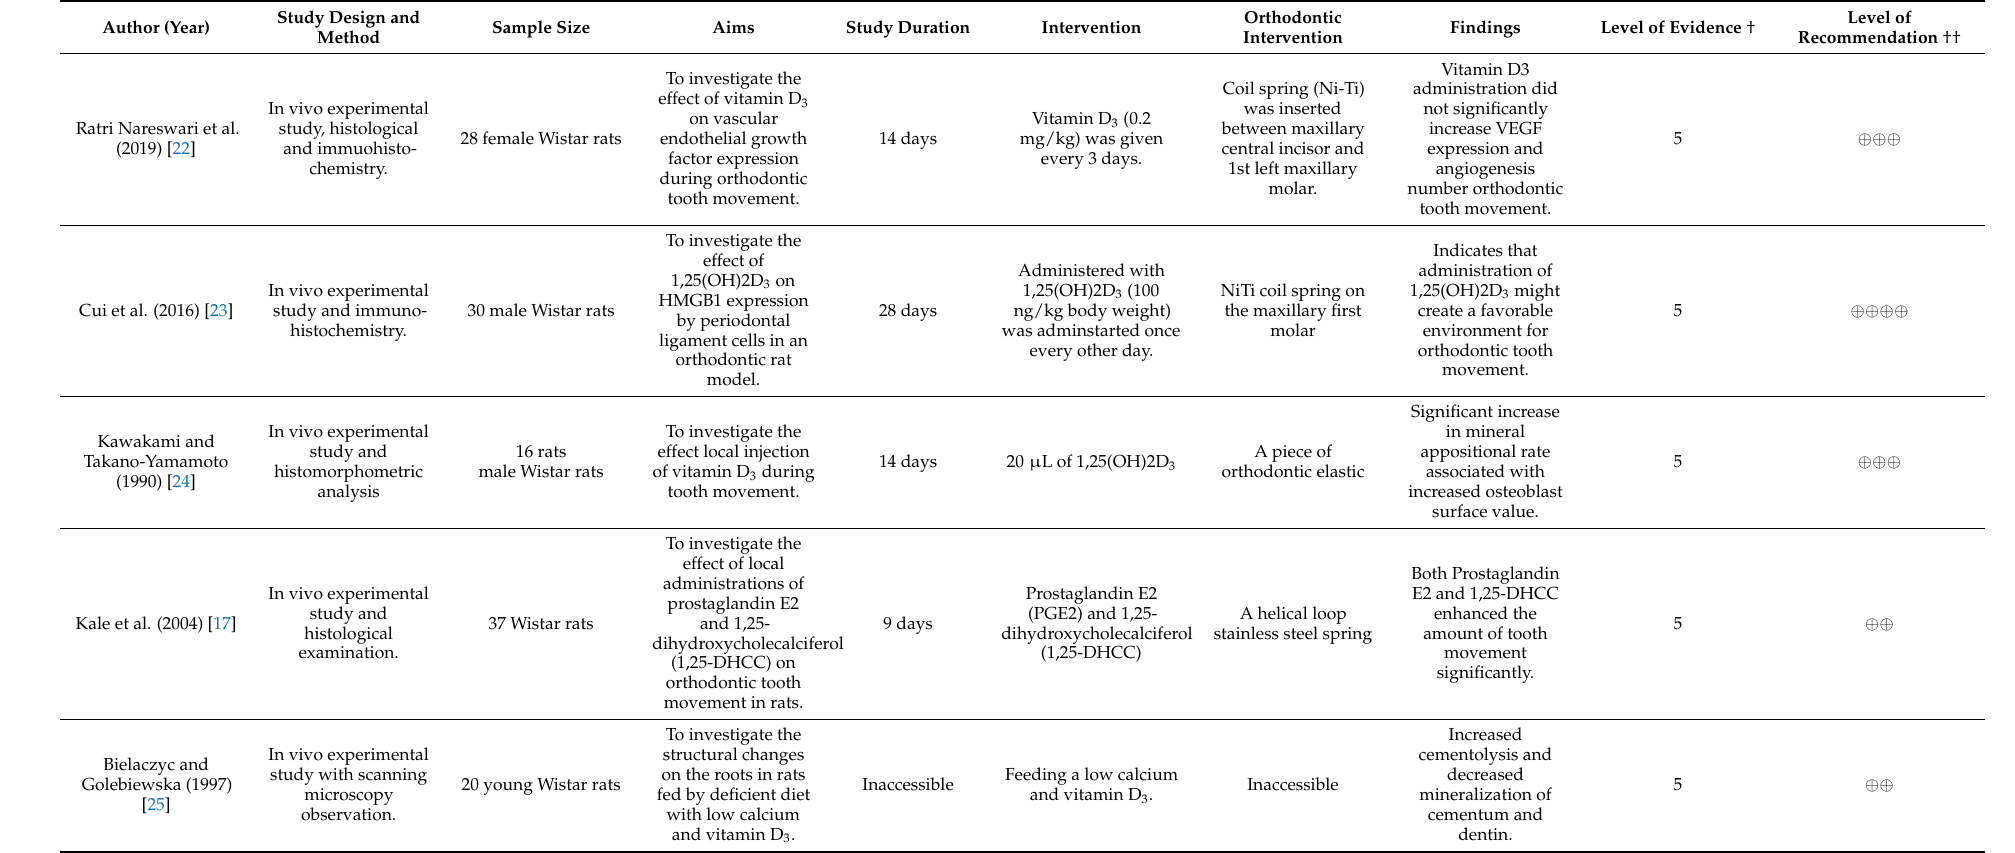
Table 1. Main characteristics of the animal studies included in systematic